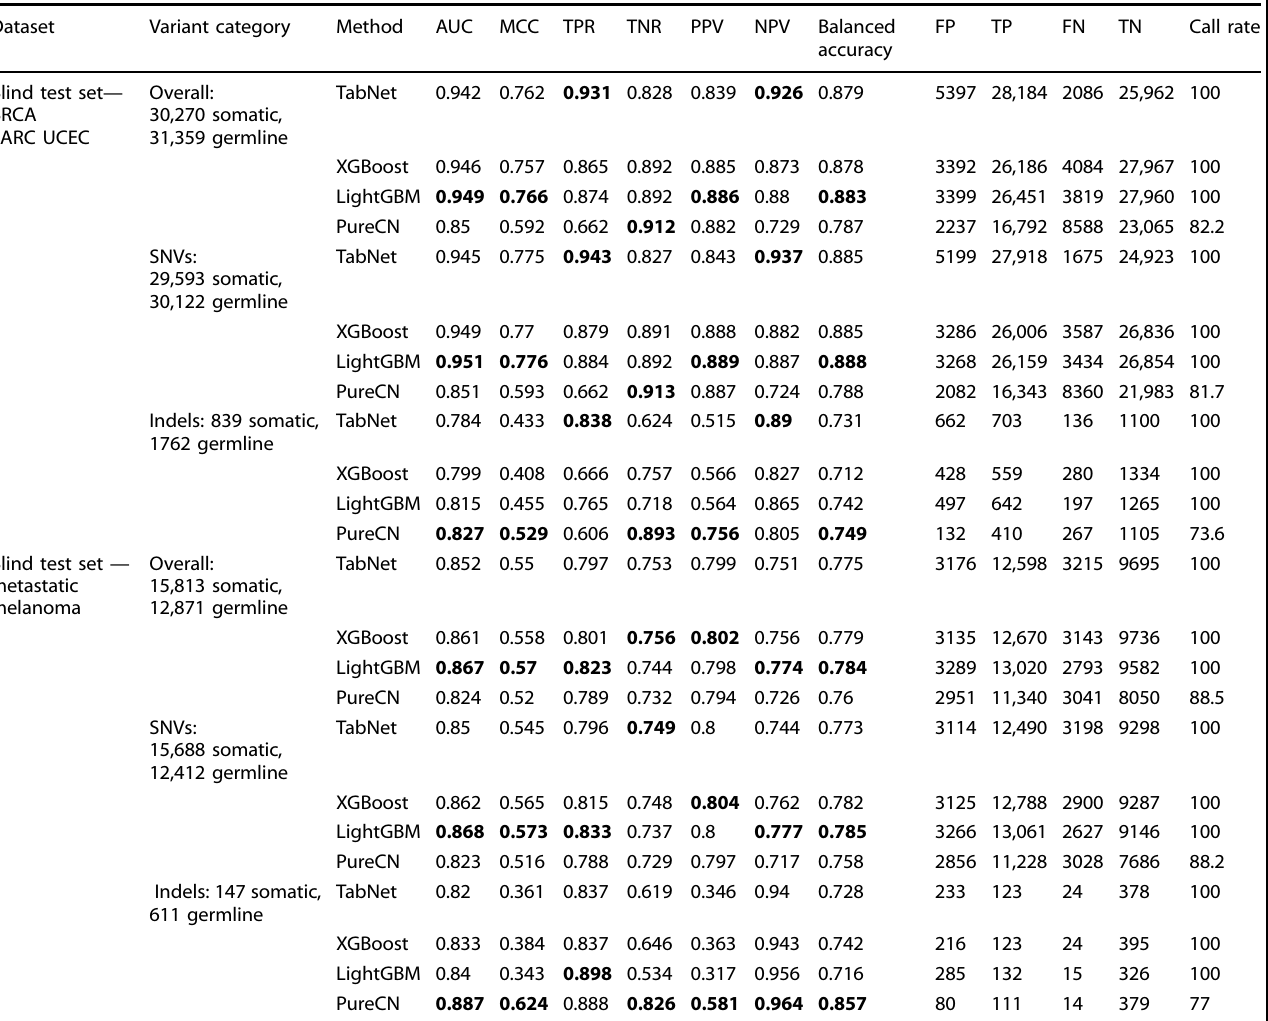
Table 1. Model performance metrics on blind holdout test